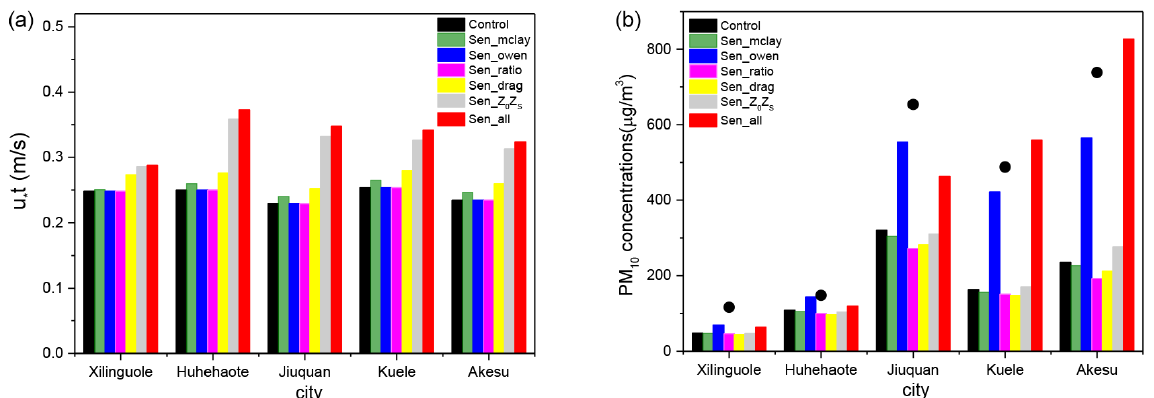
Figure 8. Comparisons of simulated averaged threshold friction velocity u ∗ t (a) and PM 10 concentrations (b) at selected sites. Black dots in (b) indicate the observed averaged PM 10 concentrations.